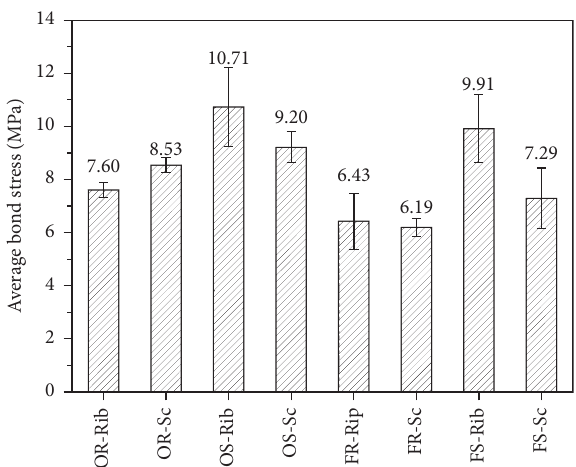
Figure 7: Comparison of bond strengths of all specimens.